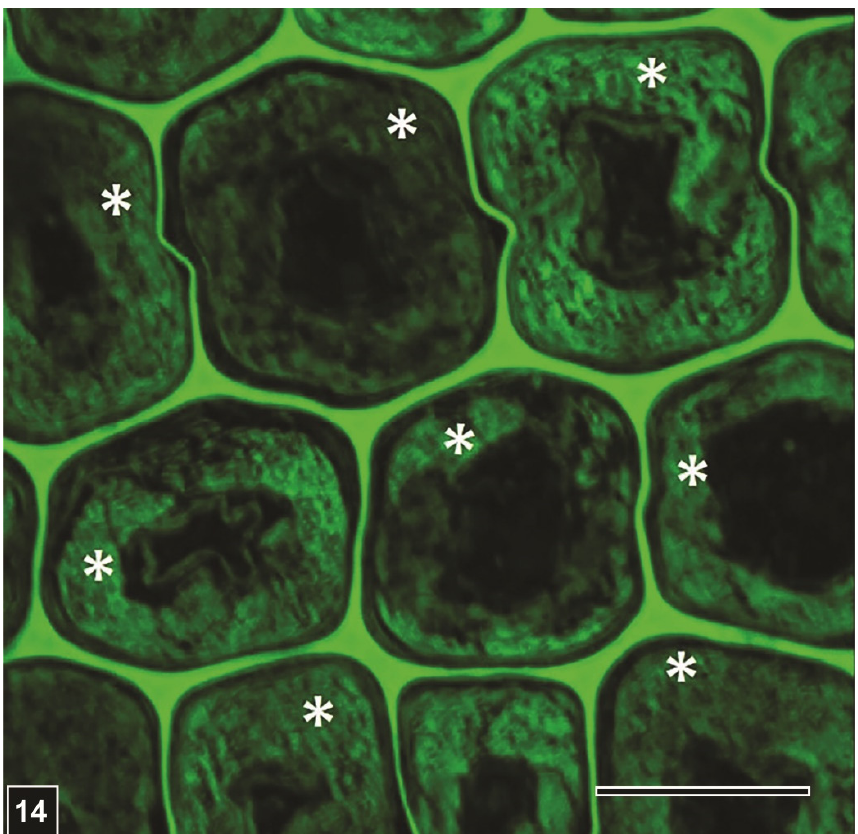
Figure 14. Confocal laser scanning micrograph (CLSM) of a transverse section through a waterlogged archaeological wood degraded by erosion bacteria. The residual material (asterisks) displays strong fluorescence for lignin. Scale bar = 15 µm. The micrograph courtesy of Prof. Jong Sik KIM, Chonnam National University, South Korea.